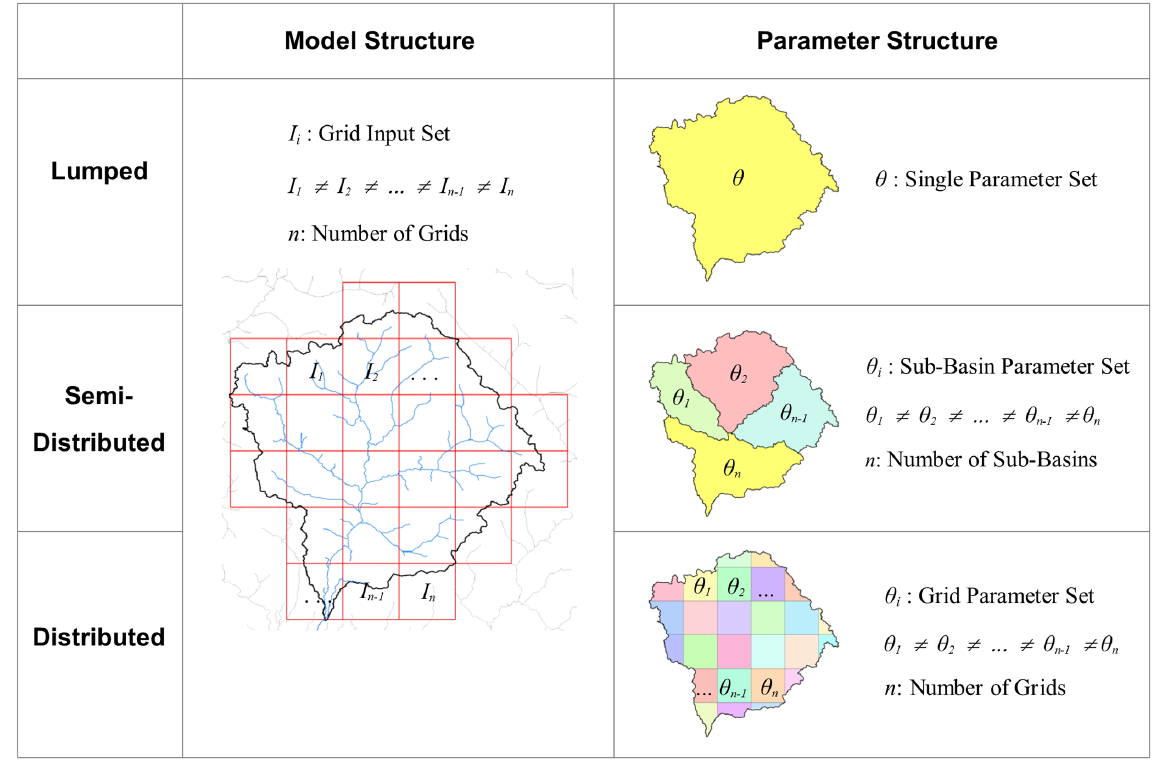
Figure 4. Model structure based on climate input grids and three different parameterization